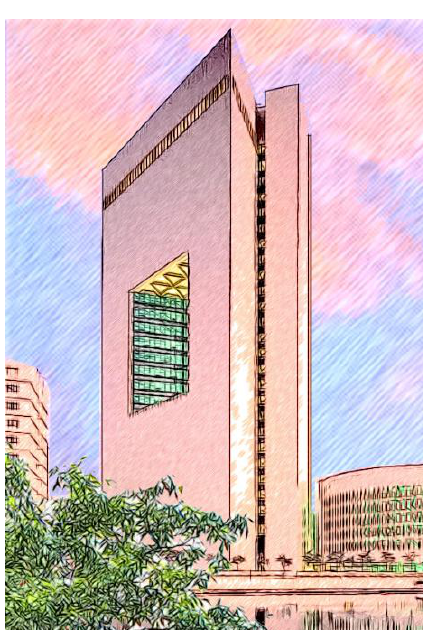
Figure 2. Cont. Figure 2. The Middle